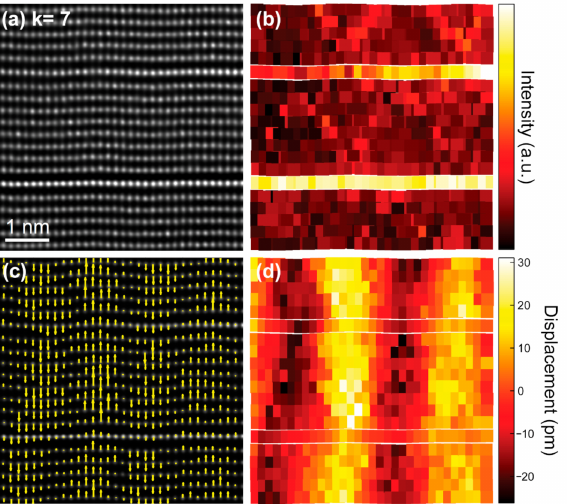
Figure 8. ( a ) Deconvoluted HAADF-STEM image of the k = 7 term revealing the undulation of the rows of Zn/In atomic columns. ( b ) Intensity map of the Zn/In atomic columns as obtained from the HAADF signal. ( c ) Atomic displacements along the (vertical) [001] direction of the Zn/In atomic columns measured relative to the center of each atomic row. The vectors in the arrow map are plotted along the displacement direction of the Zn/In cations, i.e., away from the oxygen columns. ( d ) Extracted fit of the atomic displacements for the Zn/In atomic columns plotted at their fitted